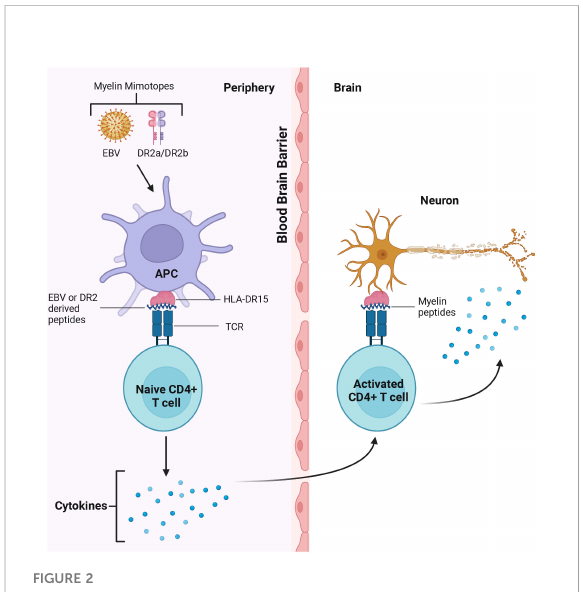
FIGURE 2 CD4+T cells cross react with Epstein Barr Virus (EBV) and DR2 derived peptides in the periphery and myelin in the brain. Myelin mimotopes could induce autoreactive CD4+ T cells by presenting EBV and DR2a/DR2b derived peptides sharing similarities with CNS self-antigens (i.e. myelin). These T cells could recognize the target antigen on microglia, leading to activation of CD4+ T cells. Activated T cells release cytokines which could trigger demyelination and axon loss, CNS in fl ammation and tissue injury.